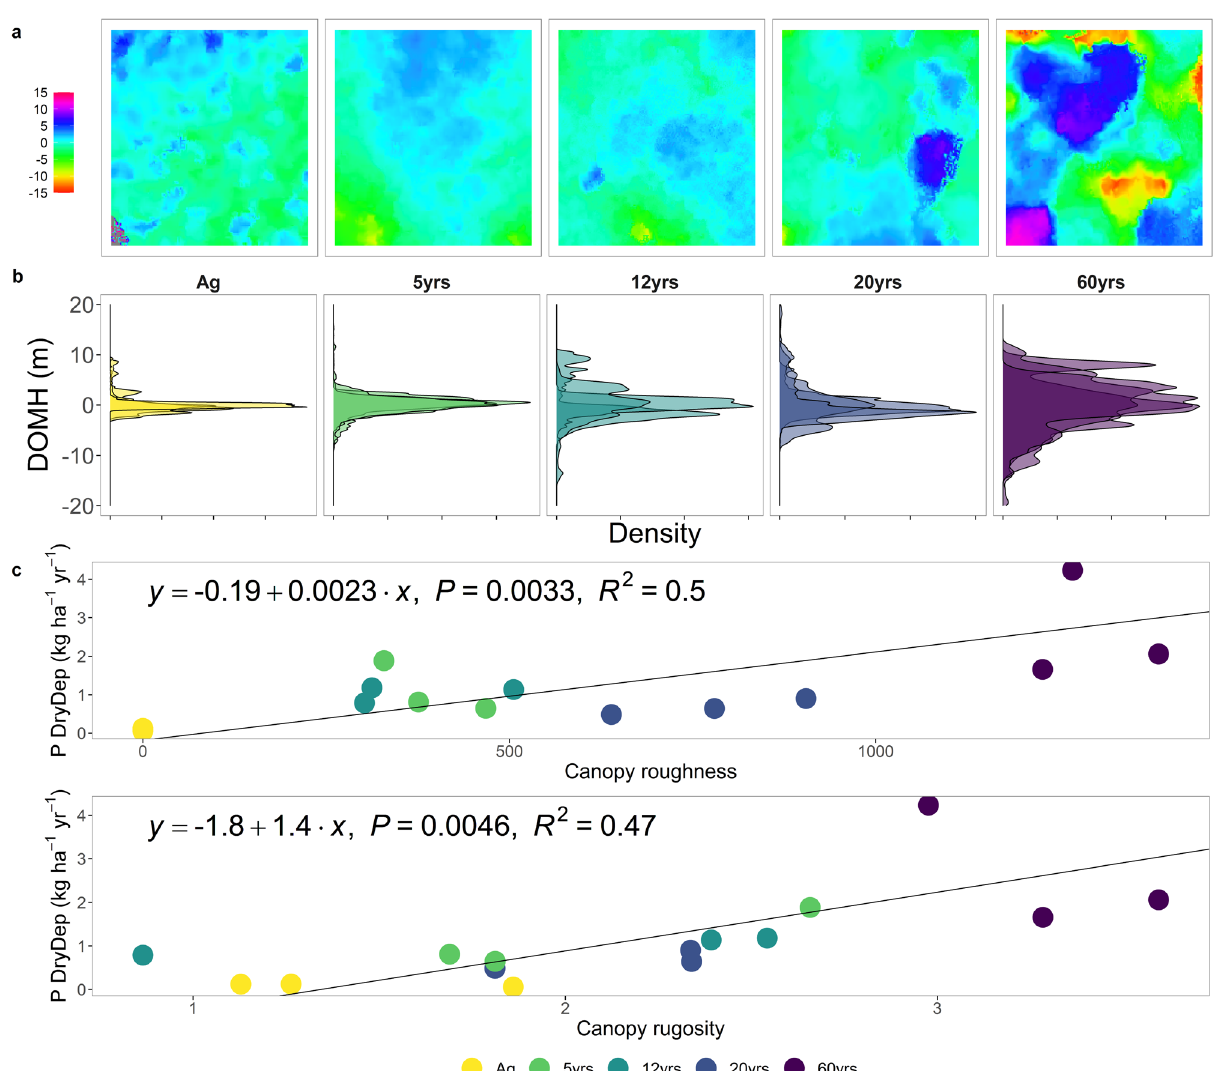
Fig. 2 Canopy complexity and annual phosphorus dry deposition along successional forest stages: agricultural fi eld (Ag), 5- (5 yrs), 12- (12 yrs), 20- (20 yrs), and 60-year-old forest (60 yrs). a Canopy height models show the deviation in canopy height (m) from the mean of a 40 × 40 m plot per successional stage. b Density distributions for three plots per successional stage displaying the deviation of mean height (DOMH, m) from the plot ’ s mean. c Canopy roughness and rugosity, based on unoccupied aerial vehicle-derived structure for motion and vegetation height, versus the annual P dry deposition. Points in ( c ) represent the plot-level measurements for annual P deposition and canopy roughness and